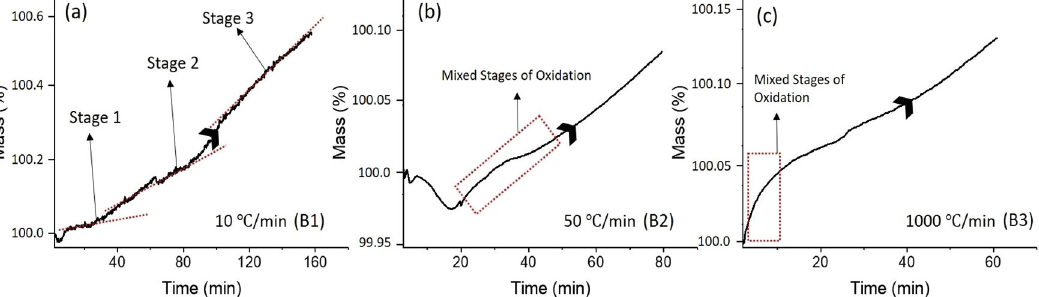
Fig. 5 TGA analysis for change in mass with a time of isothermally treated L-DED fabricated IN718. TGA plots correspond to heating rates of a 10 °C/min, b 50 °C/min, and c 1000